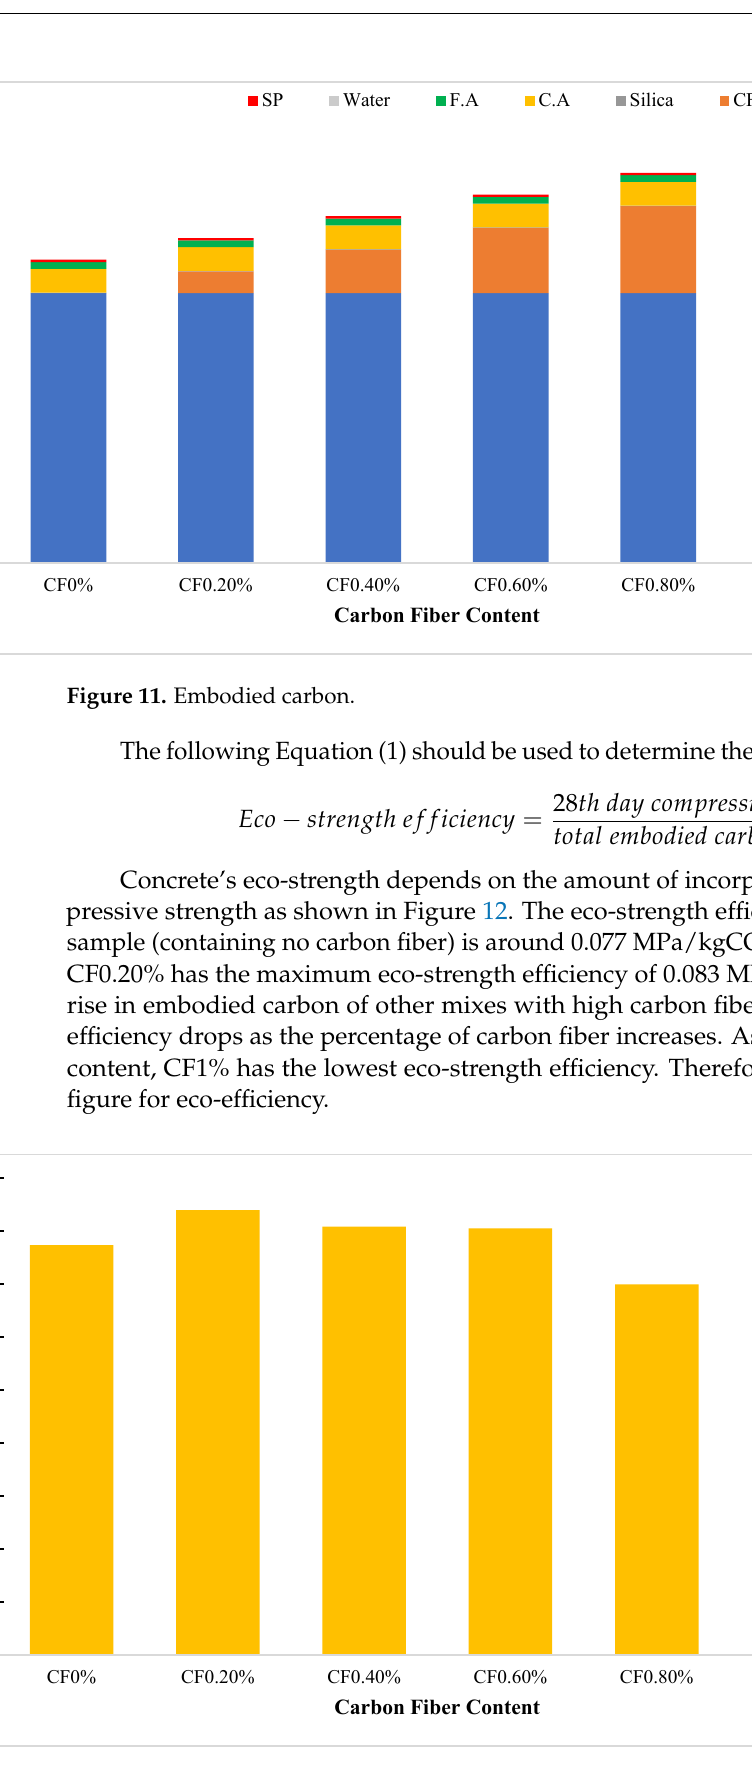
Figure 12. Eco-strength efficiency.